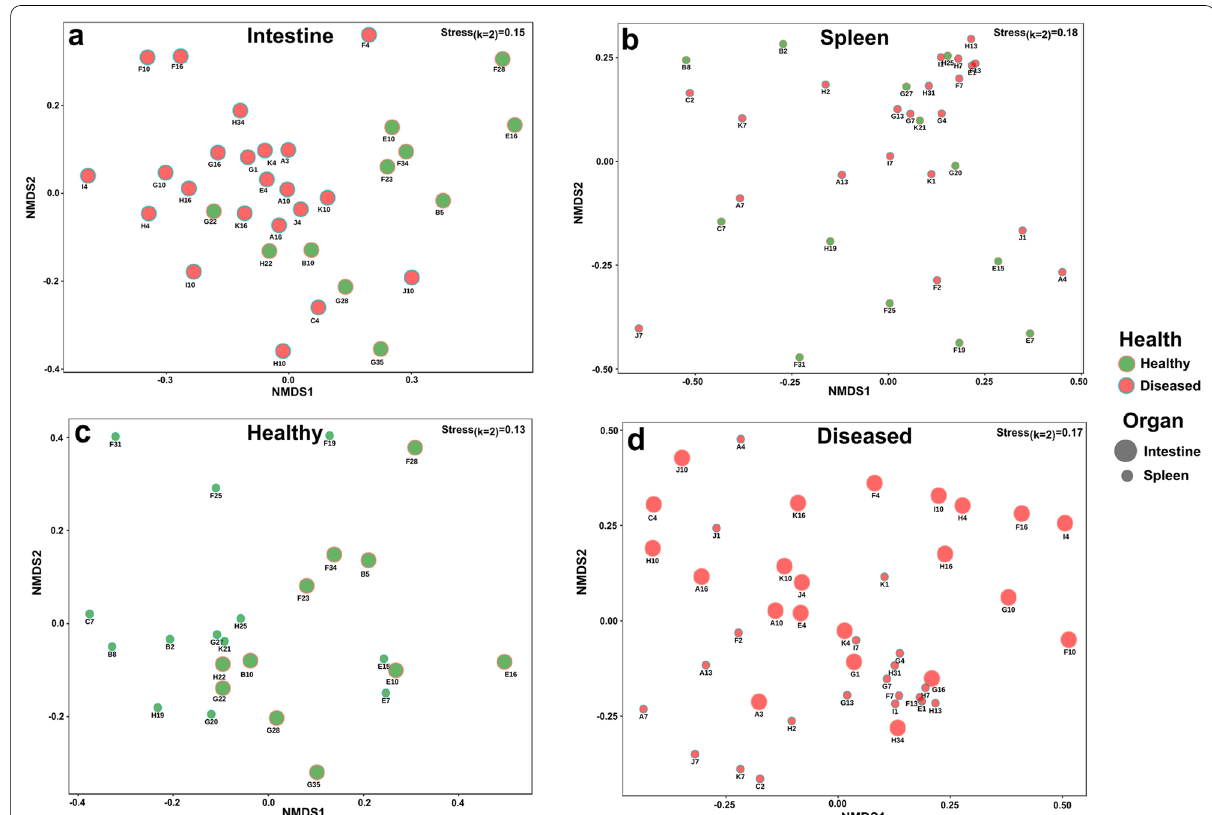
Fig. 1 An NMDS plot (Bray–Curtis dissimilarity) of the microbiota composition of the samples from fish intestines ( a ) and spleens ( b ), from healthy and diseased fish. A comparison between intestines and spleens in the fish from the same health condition is presented in ( c ) (healthy fish) and ( d ) (diseased fish). More details regarding the fish sample identity can be found in Additional file 1: Table S3